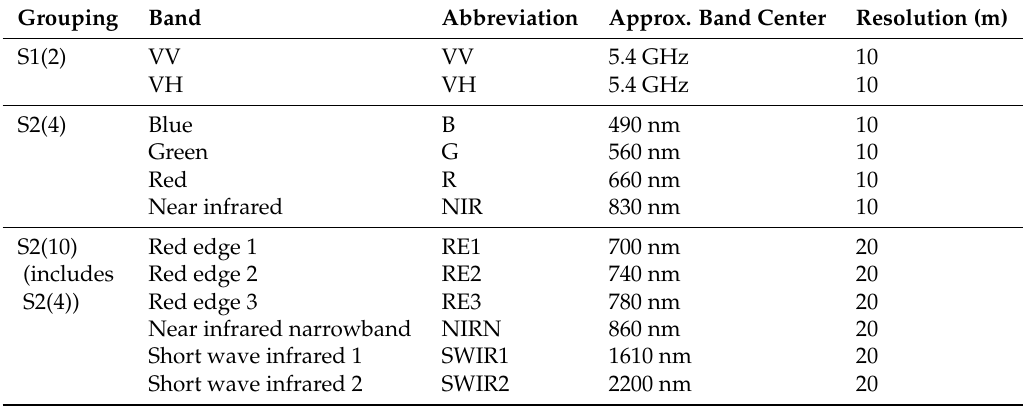
Table 2. Sentinel-1 (S1) and Sentinel-2 (S2) bands. NDVI = (NIR − R)/(NIR + R) was also computed at 10 m resolution, and NDVI together with the S2(4) bands formed the S2(5)